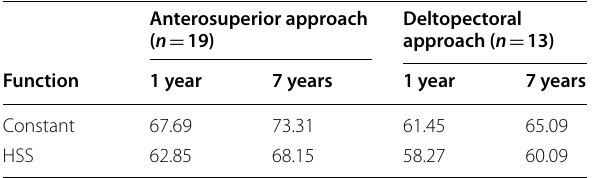
Table 2 We can see how the function (measured according to Constant and HSS) improved in the 7‑year assessment in both approaches, although there were no statistically significant differences between the results of both approaches ( p <